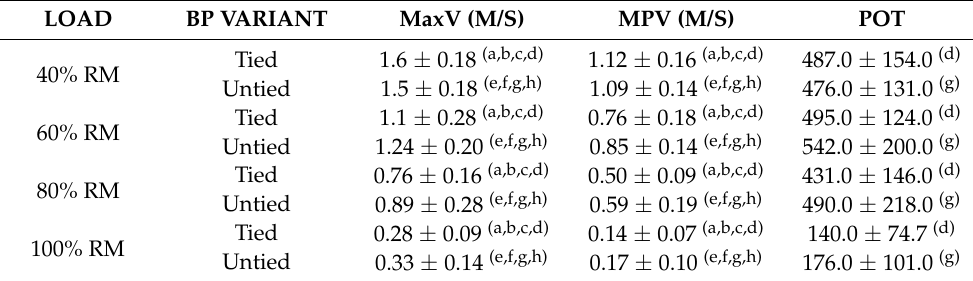
Table 2. Comparison between the velocity variables obtained in relative loads (% 1RM) during bench press lifting in untied conditions and tied with a leg/bench straps in powerlifting athletes.